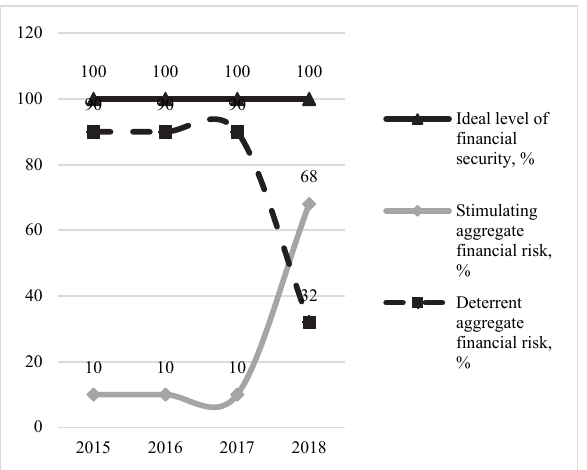
Fig. 7. Impact of restraining financial risk on the financial security level of PJSC "Berdychiv Machine Building Plant